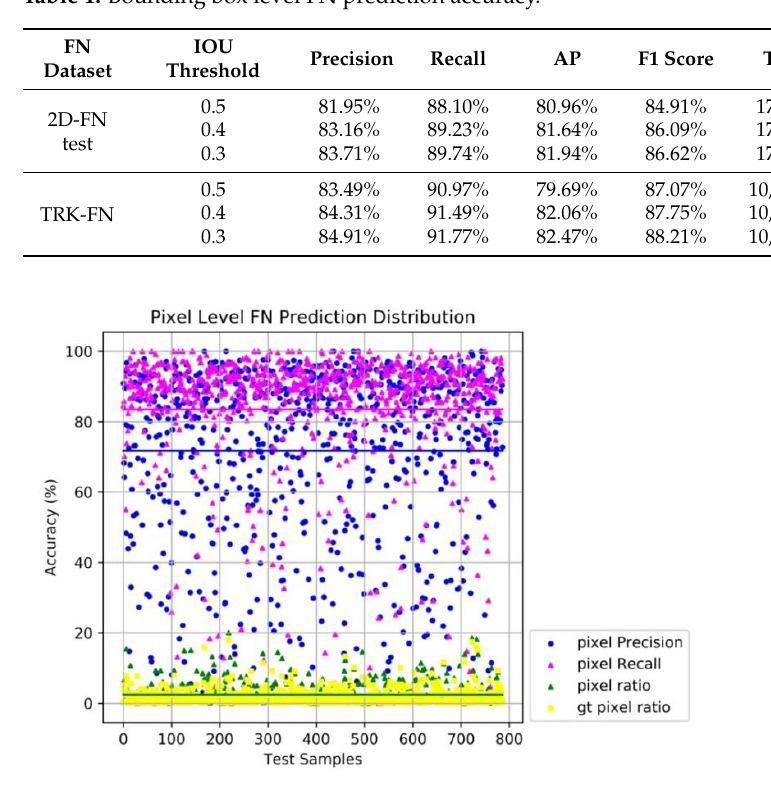
Figure 7. Pixel level FN prediction performance distribution on the test dataset of 2D-FN. Each point in the figure stands for a metric value on a test image, and the solid lines refer to the average values among all the test samples.